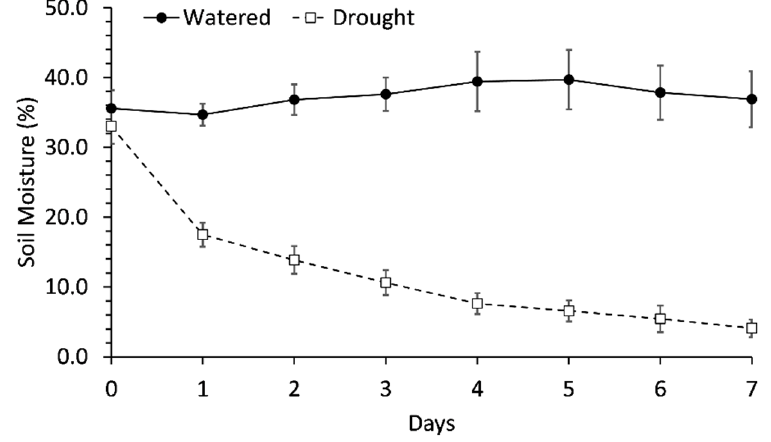
Figure 1. Soil moisture over time in pots during the last week of the experiment. Watered pots continued to receive water each day while water was completely withheld from droughted pots. Each data point represented the mean of 36 pots in each treatment. Error bars indicate standard error.